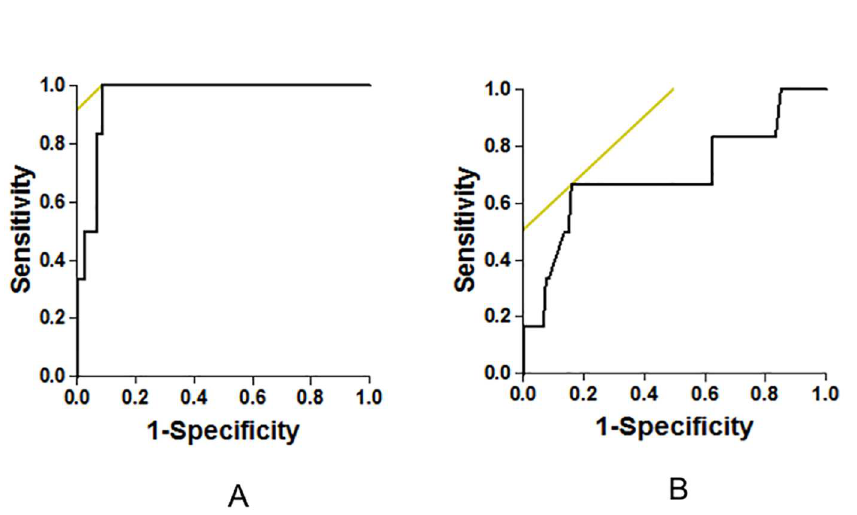
Fig 2. Receiver operative characteristic (ROC) curve analysis of the mean ferritin in the last 12 months (A) and ASDNN (B) for predictors of the cardiac T2 * (cid:20) 20 ms. ASDNN, the average of the standard deviationof all R-R intervals for all 5-minute segments in the 24-hour